Question: In one sentence, what is this figure communicating?
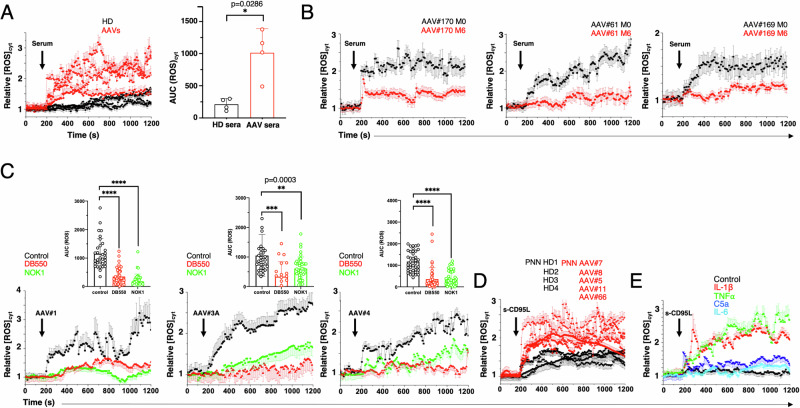
Answer: AAV neutrophils are primed to respond to sCD95L. Cytosolic ROS production ([ROS] cyt ) was measured with the fluorescent probe H2DCFDA, Ratio values ( R ) were normalized to pre-stimulated values ( R 0 ) to yield R / R 0 values (relative [ROS]). Sera from healthy donors and AAV patients were diluted (1/1000) in the extracellular recording medium (HBSS). Data are representative of three independently performed experiments. A left panel: Relative cytosolic ROS production in PNN (polynuclear neutrophils) from HDs after stimulation with sera from AAV patients ( N = 4, red) or healthy donors ( N = 4, black). For each condition, data represent mean ± SD of n = 41 cells. Right panel: Representation of areas under the curve (AUC) of the ROS production. Data represent mean ± SD; * p < 0.05 using two-tailed Mann-Whitney test. B Relative cytosolic ROS in PNN from HD after stimulation with sera from AAV patients before (M0) or after treatment (M6). For each condition, data represent mean ± SD of n = 41 cells. Data are representative of three independently performed experiments. C HD PNN were pre-treated with or without DB550 (1 µM) and then bathed with sera from AAV patients. To block CD95L/CD95 interaction, the neutralizing anti-CD95L mAb NOK-1 or isotypic control (1 µg/ml) was pre-incubated in sera for 10 min prior to incubation with HD neutrophils and relative cytosolic ROS production was measured. Inset: histograms represent mean ± SD of areas under the curve (AUC) of the cytosolic ROS response. ** p < 0.01, *** p < 0.001, **** p < 0.0001 using unpaired and two-tailed Mann-Whitney test. D Cytosolic ROS in PNN isolated from HD or AAV patients exposed to sCD95L (100 ng/ml). For each condition, data represent mean ± SD of n = 41 cells. Data are representative of three independently performed experiments. E HD neutrophils were pre-treated in the presence or absence (control) of the pro-inflammatory cytokines TNF (5 ng/ml), IL-1β (10 ng/ml), IL-6 (10 ng/ml) or C5a (10 ng/mL) for